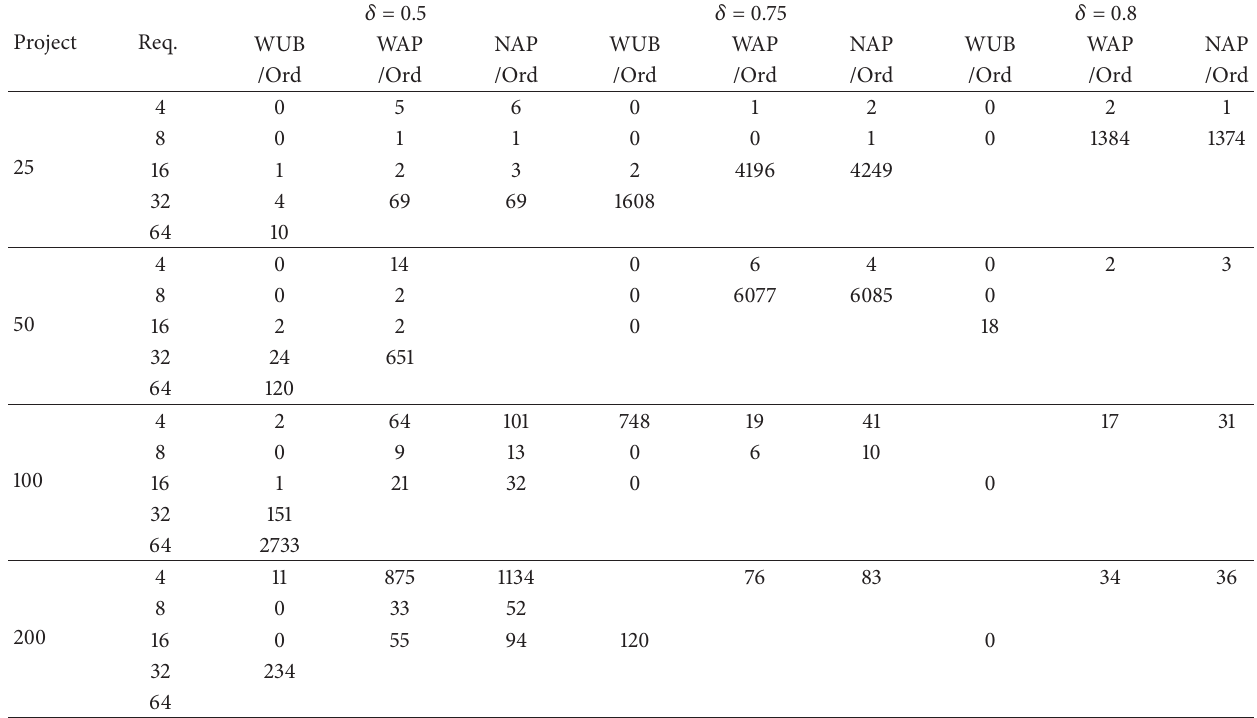
Table 3: Comparison of WUB/Ord with Apriori sorting process WAP/Ord and NAP/Ord in (ms).